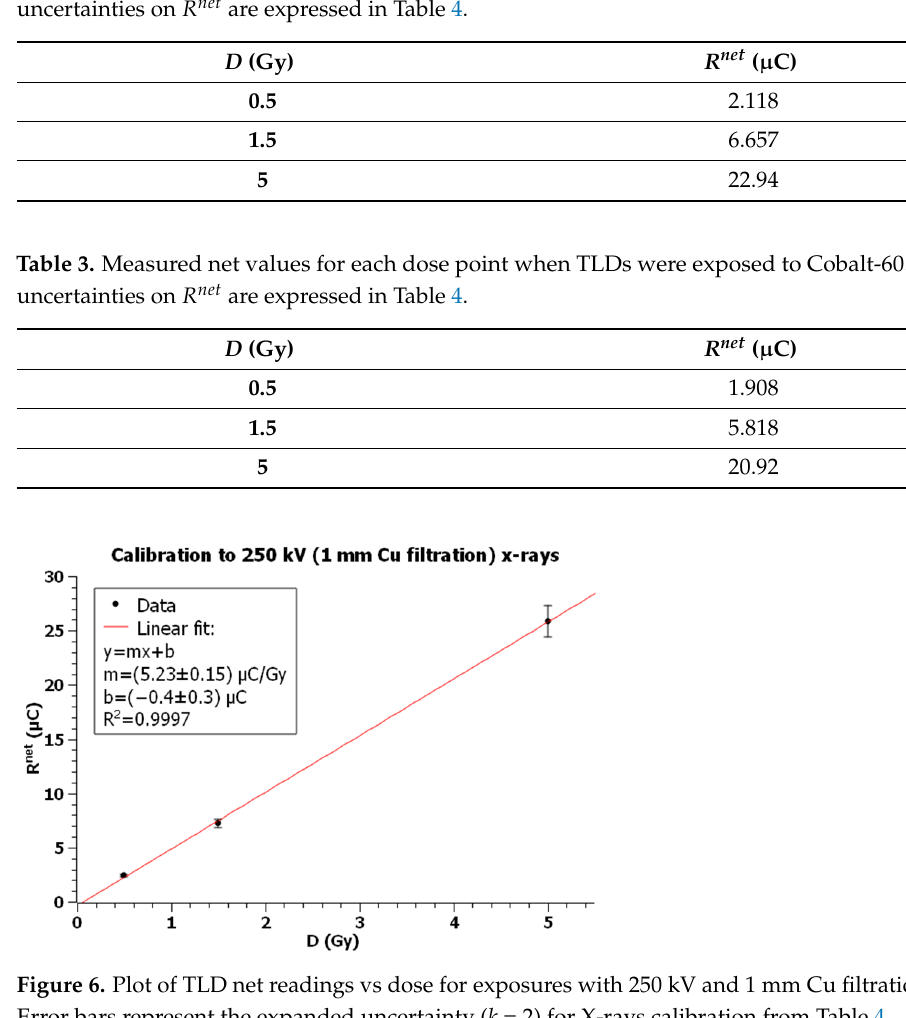
Table 4. Relative uncertainty analysis for TLD calibration to 250 kV X-rays, with 1 mm Cu added filtration, to Cs-137 and to Co-60.